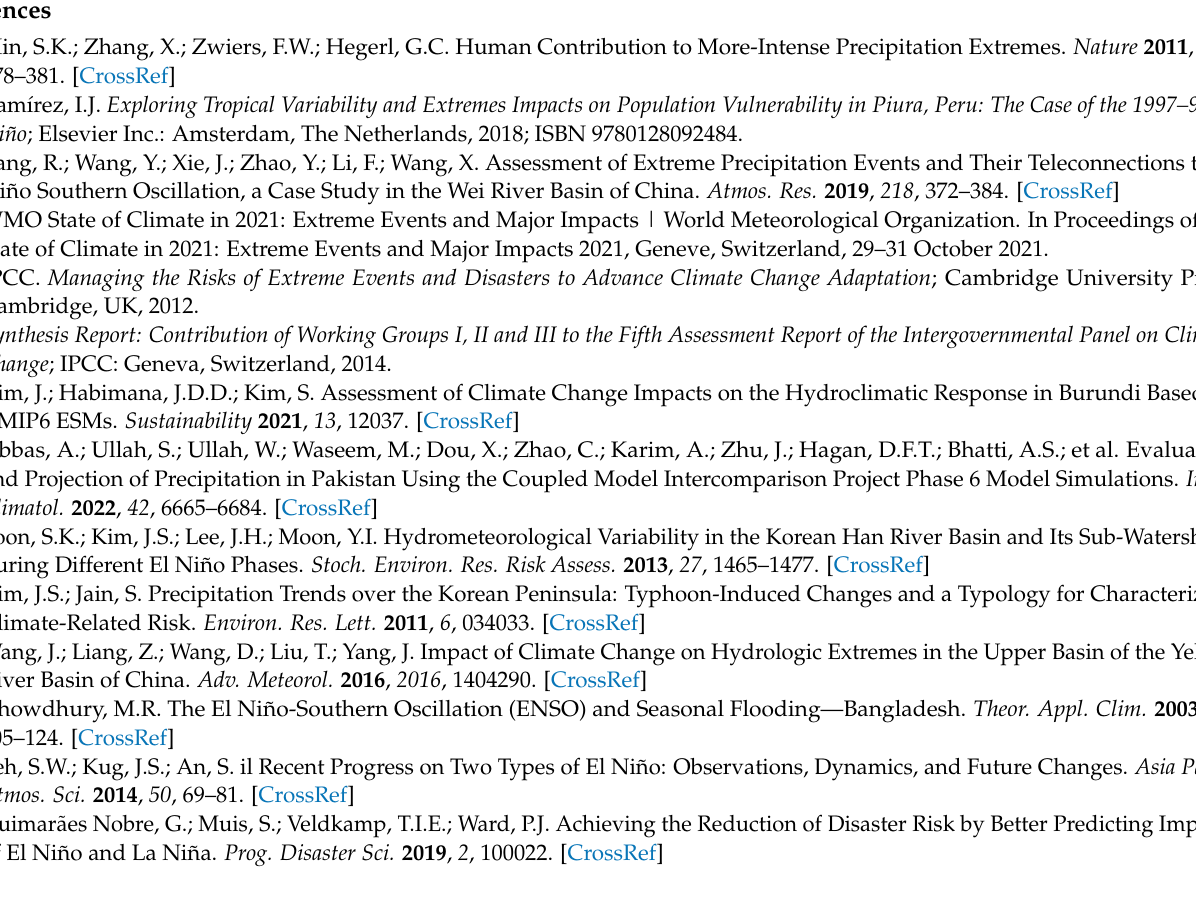
Table S3(a): Temporal variability of RAI in the Southwest Monsoon; Table S3(b): Temporal variability of RAI in the Southwest Monsoon; Table S3(c): Temporal variability of RAI in the Southwest Monsoon; Table S3(d): Temporal variability of RAI in the Southwest Monsoon; Table S4. Correlation between ENSO, IOD and RAI; Table S5: Correlation between ENSO, NINO34, IOD and